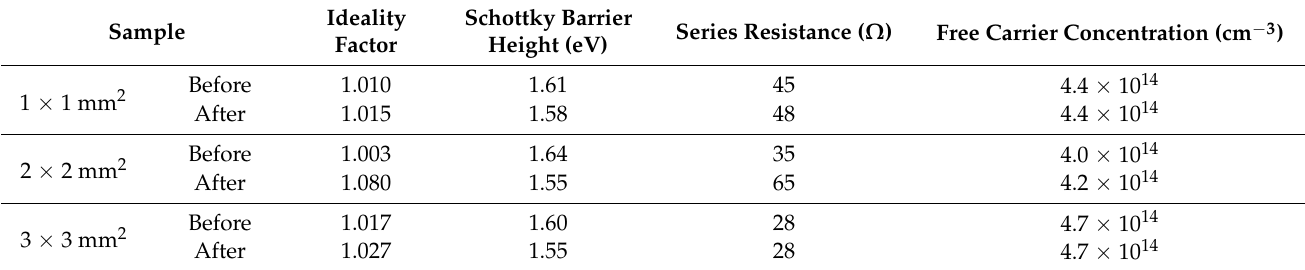
Figure 4. Measured electrical characteristics of 4H-SiC detector with active surface area of 1 × 1 mm 2 before and after radiation testing at room temperature: ( a ) I-V characteristics and ( b ) C-V characteristics. Table 1. SBD parameters before and after radiation testing.